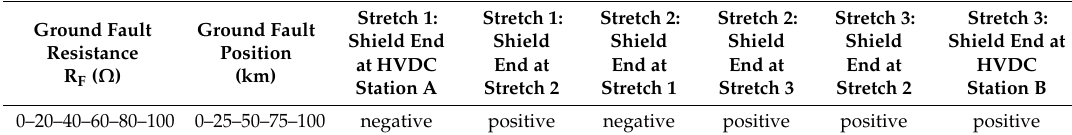
Table 7. Polarities of currents in shields with ground fault in Cable A, Stretch 3. Polarity of currents at ends of the